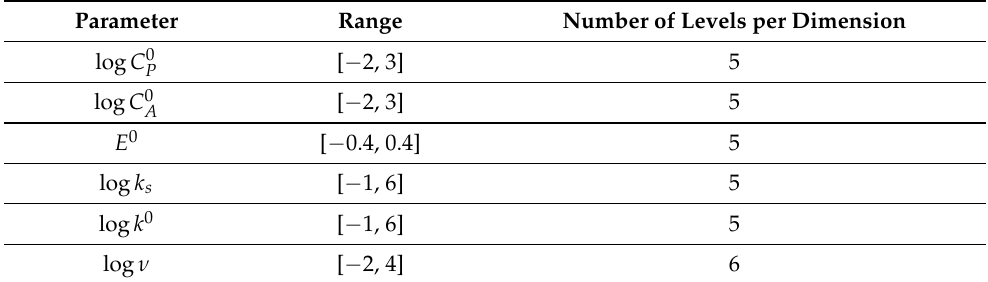
Table 1. Combinatorial space used to generate CV responses in an EC mechanism along with the number of levels used in the exhaustive search.